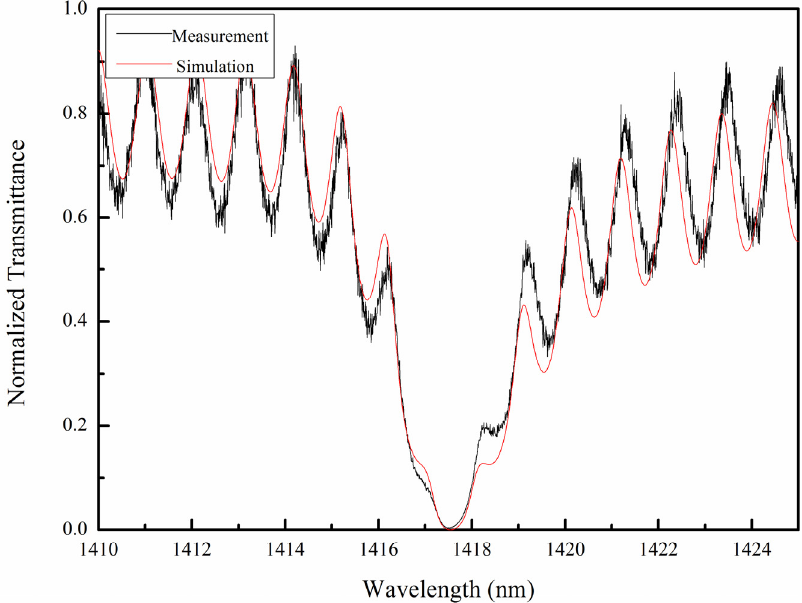
Figure 2. The transmission spectrum for the GMR chips (black) and the RCWA simulation (red) in an air environment. The resonance wavelength was 1,417.5 nm. The simulation parameters were in accordance with the AFM morphology results for the GMR chip. The side band ripples were the result of interference from the